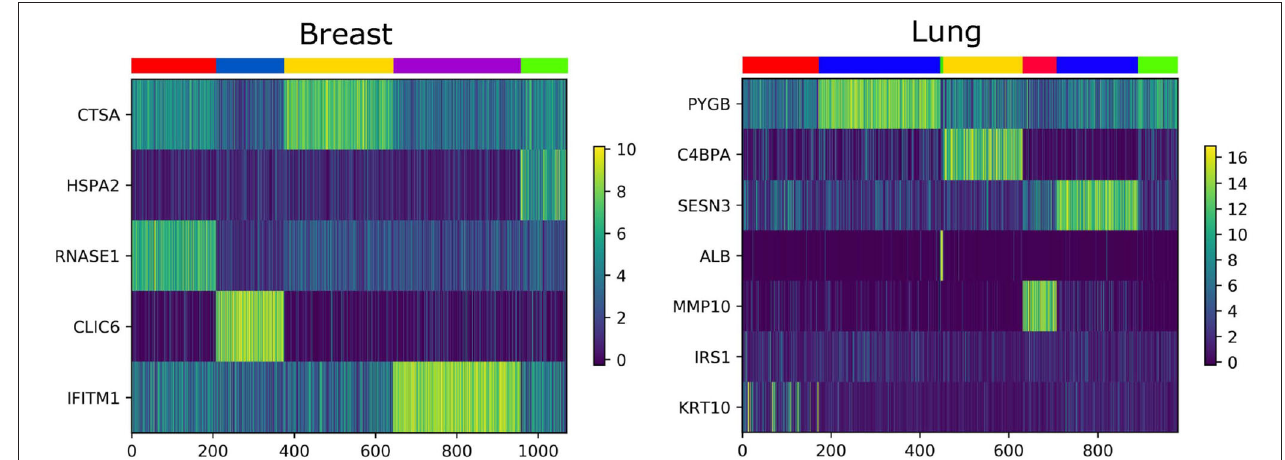
FIGURE 6 | The heat map of essential gene expression